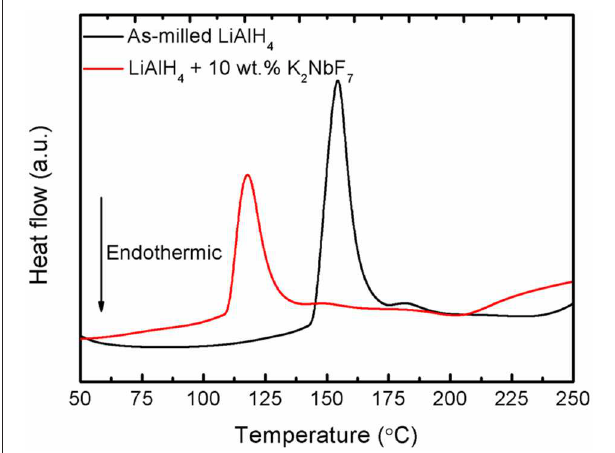
FIGURE 4 | DSC traces at various heating ramps of the LiAlH 4 when (A) as-milled and (B) with 10 wt.% of K 2 NbF 7 .